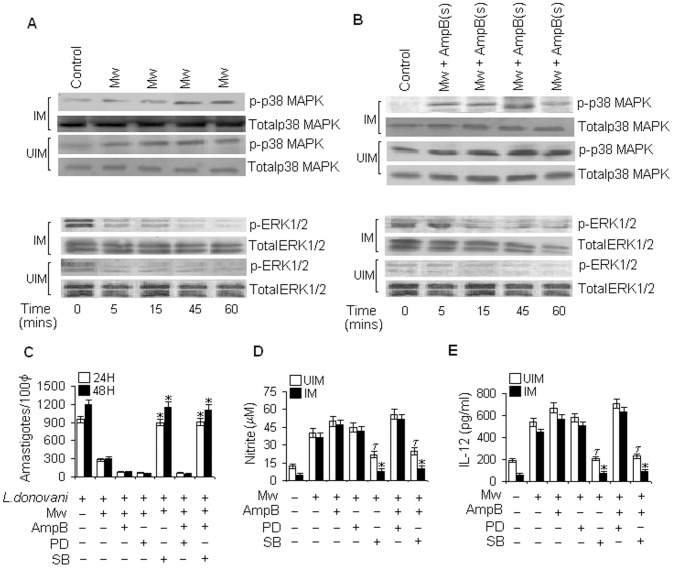

Mw mediated effector function depends on the reciprocal activation of p38 mitogen-activated protein kinase (p38MAPK) and extracellular signal-regulated kinase (ERK)–1/2 (A–E).Uninfected (UIM) or Leishmania infected macrophages (IM) were treated for 0, 5, 15, 45 and 60 minutes with Mw (A) or Mw plus AmpB (0.1 µg/ml) (B). Western blotting was performed with anti-pERK1/2, pp38MAPK, p38MAPK, and ERK1/2 as described in Materials and Methods. (C) Macrophages were pretreated with SB203580 (SB; 10 µg/ml) or PD098059 (PD; 100 µmol/L) (See Materials and Methods) for 2 h followed by Leishmania infection and then treated with Mw or Mw plus AmpB for 24 h or 48 h. Intracellular parasites were counted per 100 macrophages after Giemsa staining. Pretreatment with SB203580 significantly inhibited Mw or Mw plus AmpB mediated parasite killing, compared to corresponding Mw or Mw plus AmpB treated infected controls. *P<0.001 for SB203580; paired two-tailed Student’s t-test. (D) Macrophages (1×106 cells/ml) cultured in a 24-well plate were pretreated and infected as described in Figure 3. For maximum nitrite generation, cell-free supernatants were collected after 48 h of infection and subjected to Griess assay method as described in the Materials and Methods. (E) Cell free supernatants were collected after 24 h from macrophage culture, pretreated and infected as described previously, for estimation of IL-12 release by sandwich ELISA. Pretreatment with SB203580 significantly inhibited Mw or Mw plus AmpB mediated NO generation and IL-12 release, compared to corresponding Mw or Mw plus AmpB treated infected controls. *P<0.001 compared to infected macrophages. τP<0.001 compared to uninfected macrophages; paired two-tailed Student’s t-test. On the lower panel (A) and (B) respective densitometry data is shown. The experiments were repeated thrice, yielding similar results and data were expressed as mean ± SD.